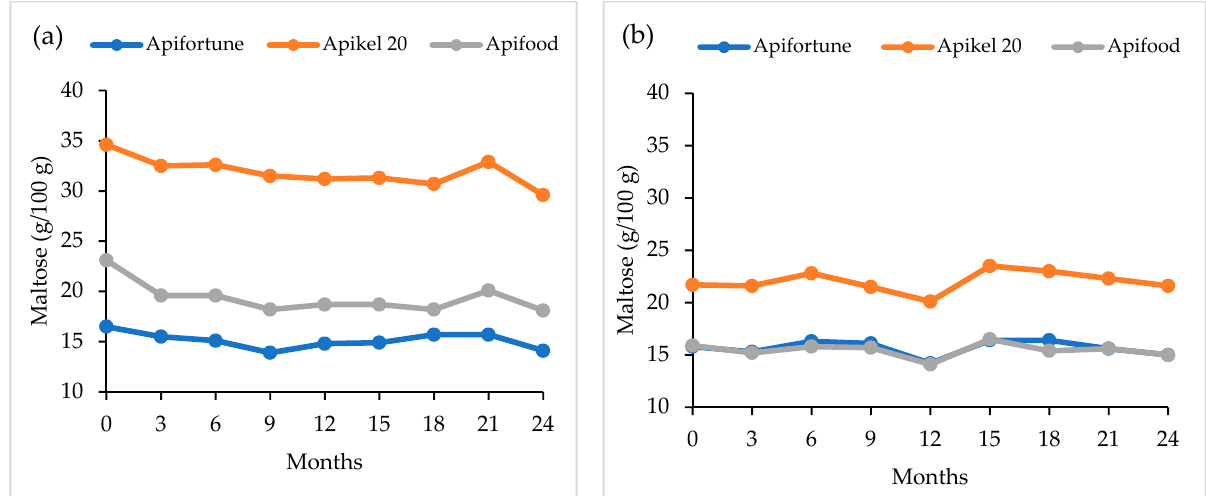
Figure 11. Changes of maltose content in syrups during storage at about 20 °C ( a ) from 2012 and ( b ) from 2013.